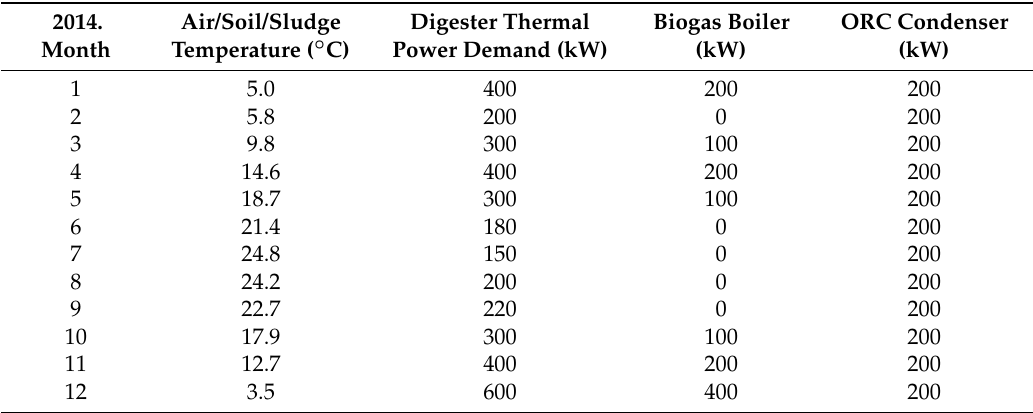
Table 11. Thermal power demands for the MGT system with the ORC and heating digester.